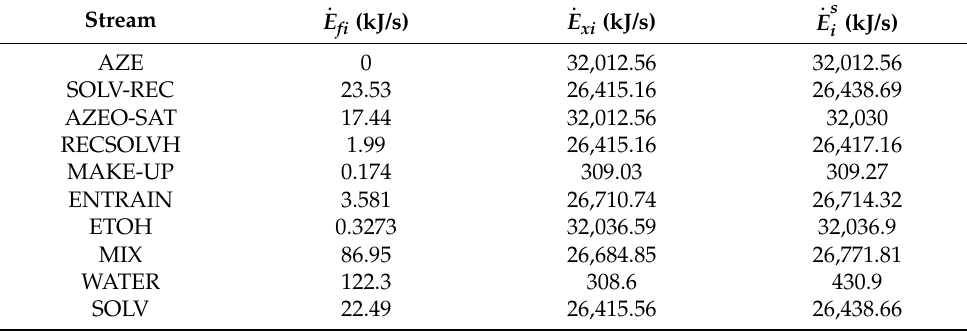
Table 2. Exergy flow in each of the process